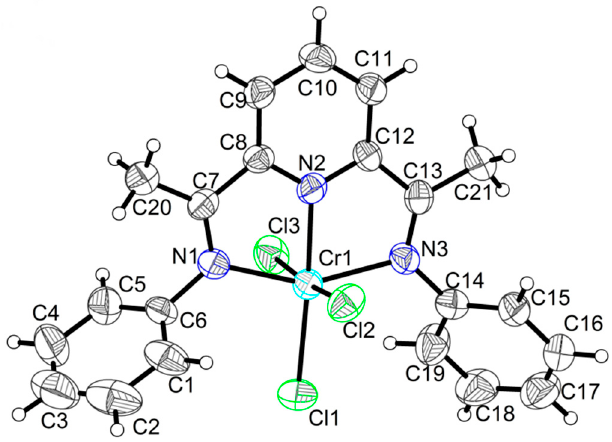
Figure 2. The molecular structure and crystallographic numbering scheme for complex 2.